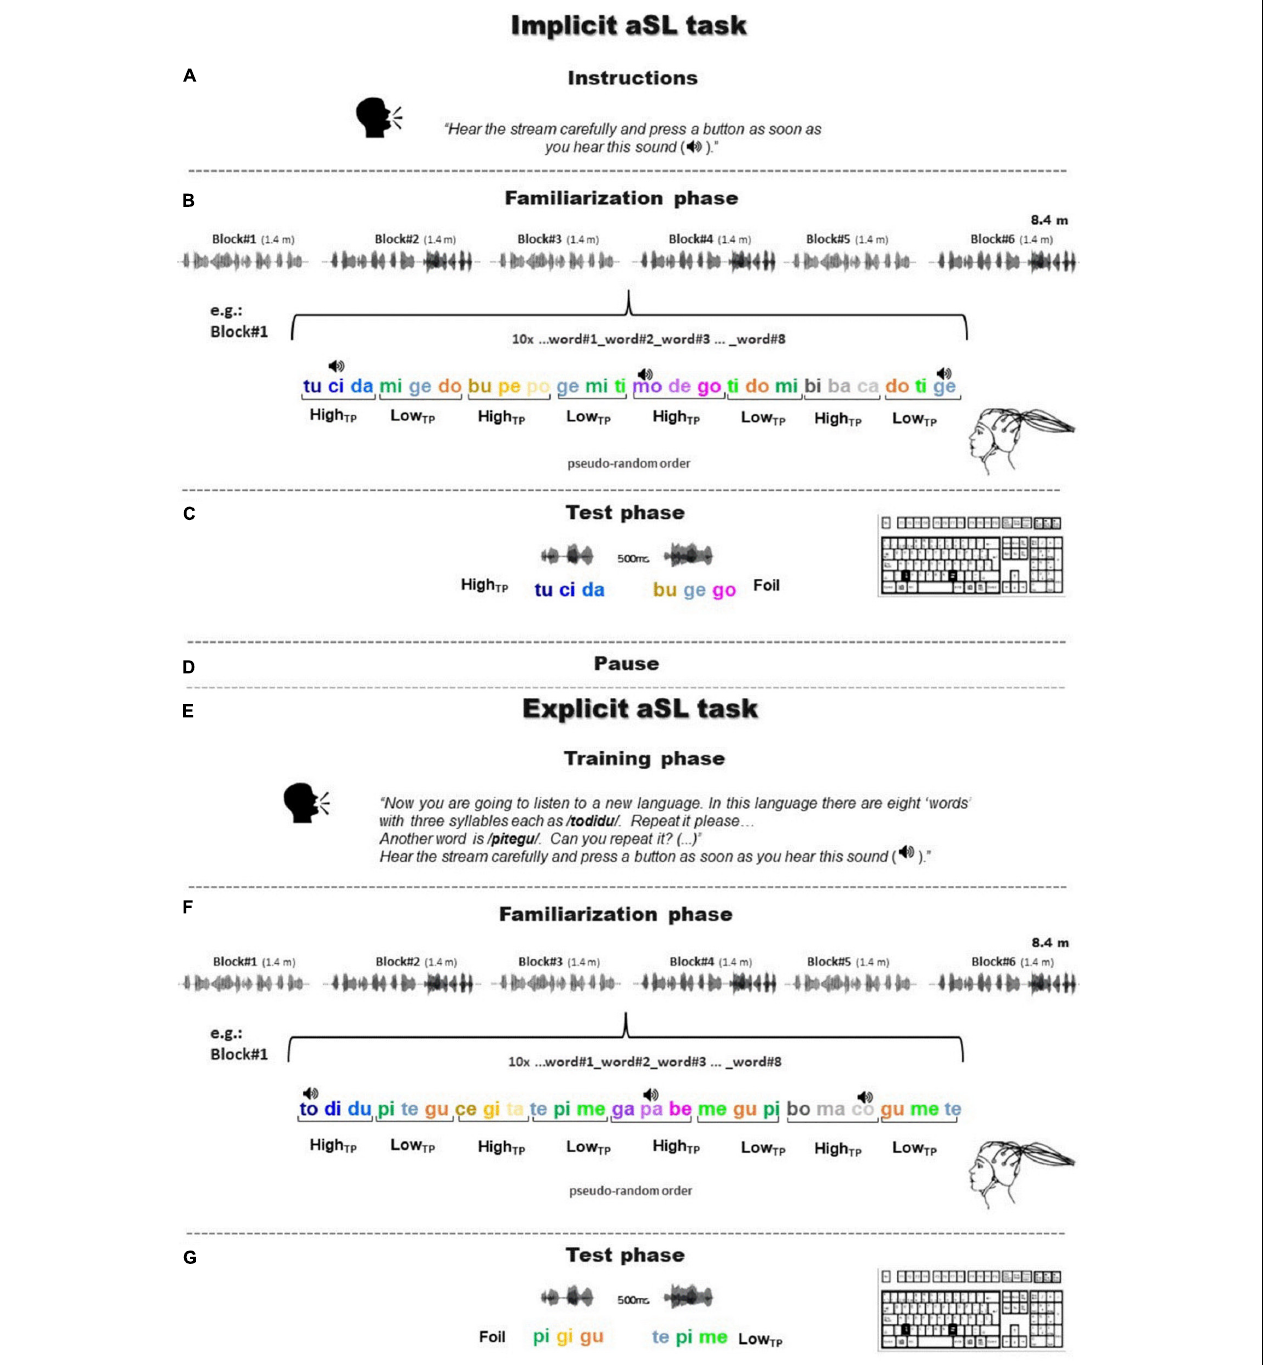
FIGURE 1 | A visual summary of the experimental design. Panels (A–G) illustrate the timeline of the experimental procedure in which the implicit and, subsequently, the explicit aSL tasks were administered. Each aSL task comprised three parts: instructions, familiarization phase, and test phase. Each task was initiated with specific instructions (A,E) that determined the conditions under which the aSL task was performed: (A) implicit instructions (i.e., without knowledge of the stimuli or the structure of the stream) or (E) explicit instructions (i.e., with explicit knowledge or pre-training on the “words” presented in the stream). In the familiarization phase of both tasks (B,F) during which EEG data were collected, the participants were presented with a continuous auditory stream of four high-TP and four low-TP “words,” with chirp sounds (depicted as a speaker icon in the figure) superimposed over specific syllables. The chirp sounds could emerge at any of the three syllabic positions of the “words,” which precluded its use as a cue for stream segmentation. During this phase, the participants had to perform a chirp detection task. Then, a test phase (C,G) consisting of a 2-AFC task asked the participants to indicate which of the two-syllable sequences (a “word” and a foil) sounded more familiar, considering the stream heard on the familiarization